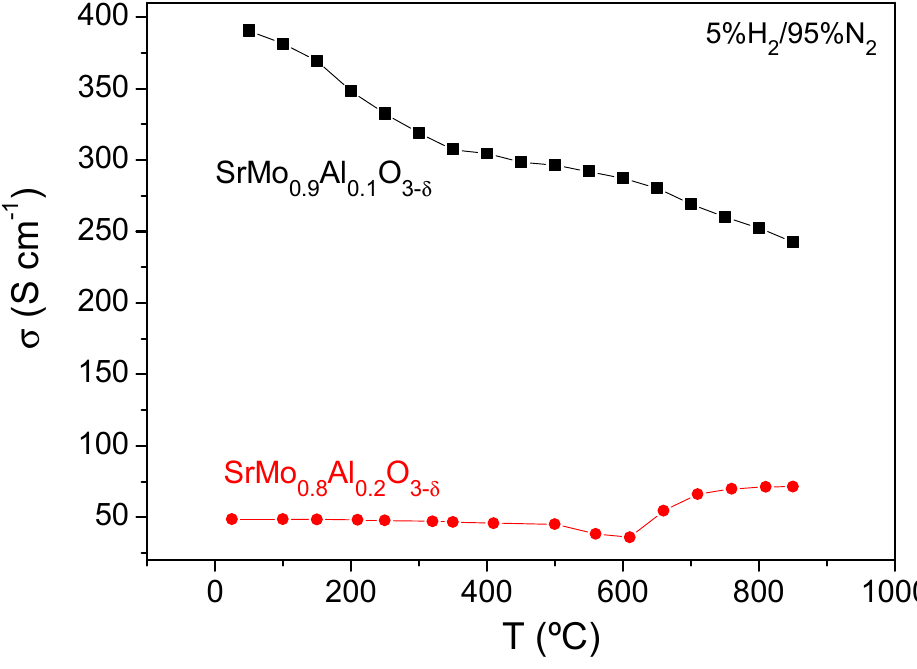
Figure 9. The dc − conductivity as a function of temperature for SrMo 1 − Al x O 3 − δ (x = 0.1 and 0.2). Figure 9. The dc-conductivity as a function of temperature for SrMo